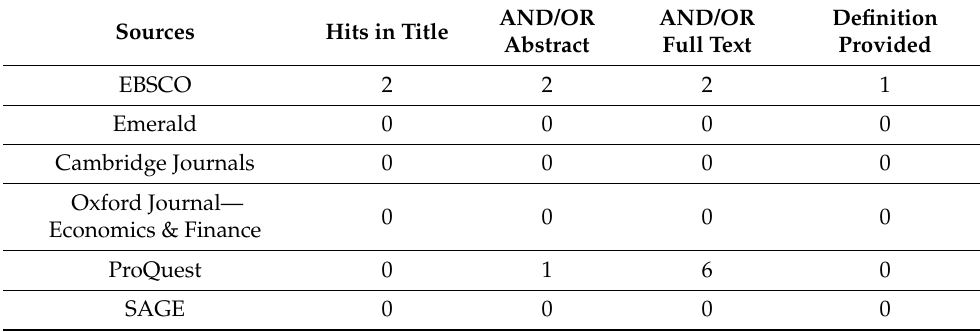
Table 2. Counts of the word PayTech in data